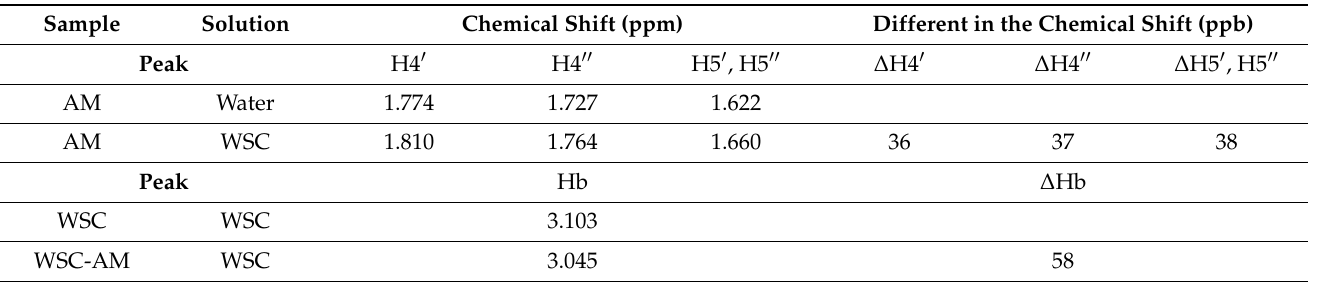
Figure 8. ( Right ) Expanded and ( left ) full 1 H NMR spectra of ( a ) WSC, ( b ) AM, and ( c ) AM–WSC peak region in the WSC solution. Table 1. Chemical shifts of H4 and H5 peaks of AM and Hb of WSC in the WSC solutions (500 µ g/mL) and the difference in chemical shift compared to that in water.